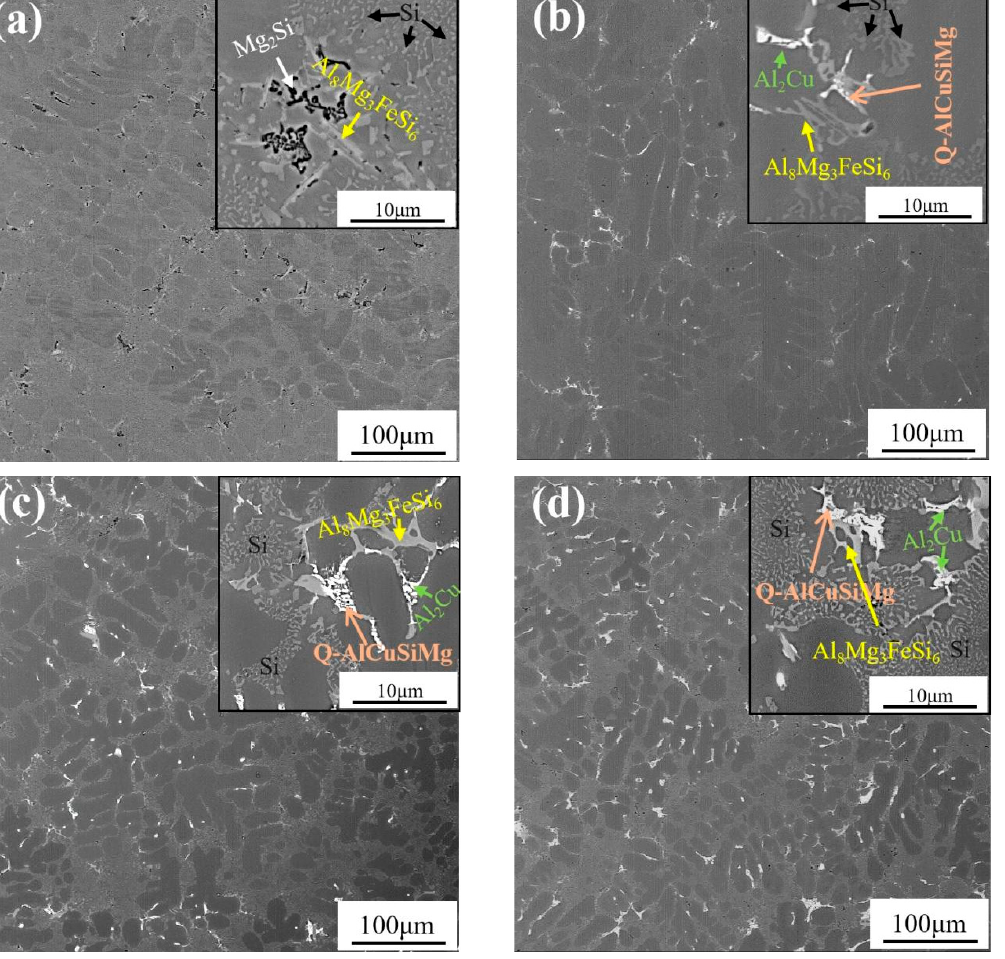
Figure 2. SEM-BSE images of as-cast alloy ( a ) A1, ( b ) A2, ( c ) A3, ( d ) A4.